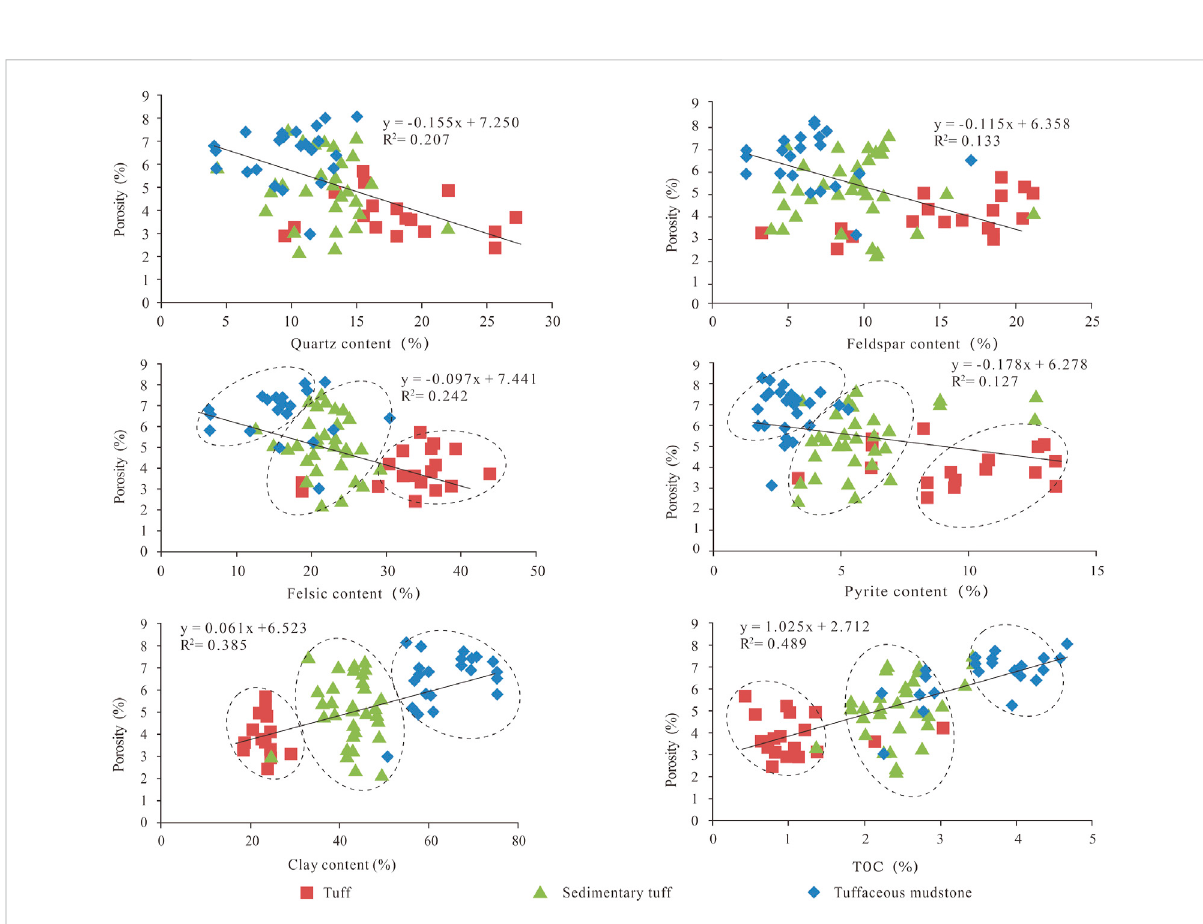
FIGURE 10 Scatter diagram of mineral composition, TOC, and